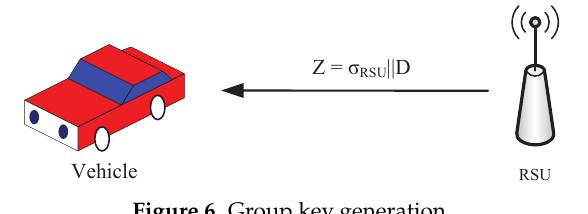
Figure 6. Group key